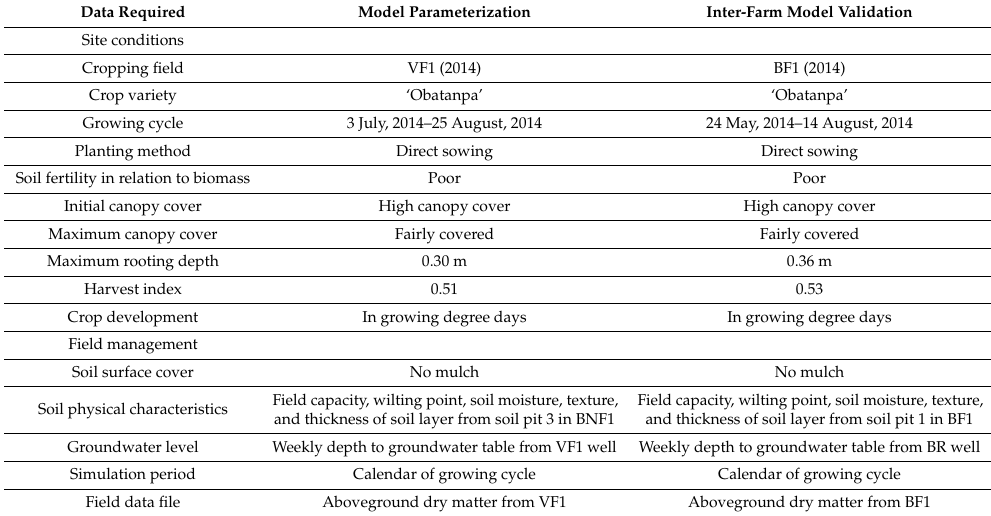
Table 1. Modified parameters and field data used for the parameterization and validation of the AquaCrop model for maize.